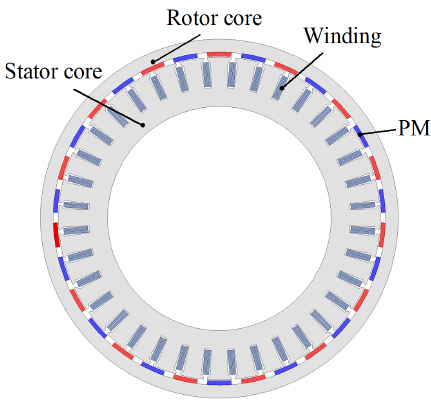
Figure 1. Structure of LSPMM. Table 1. Design parameters of the LSPMM.